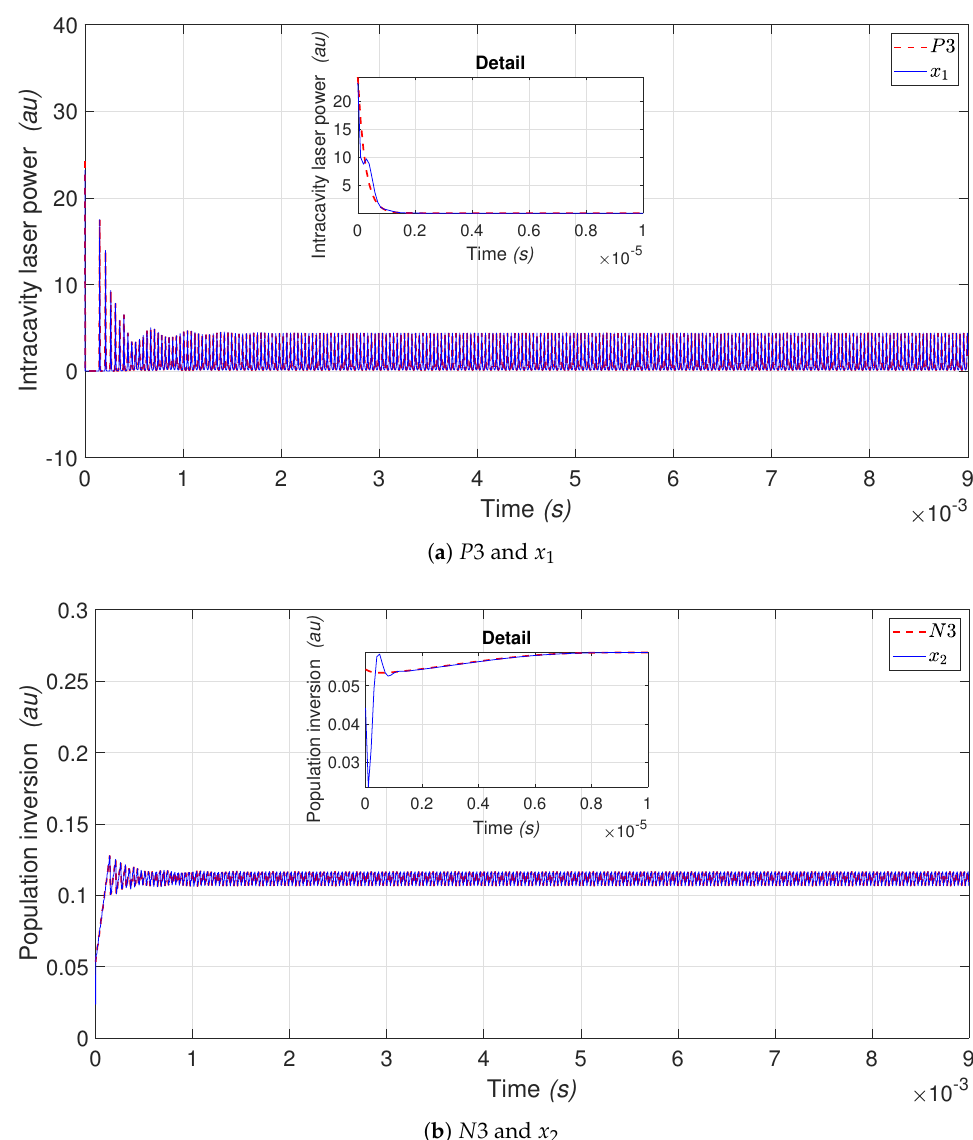
( b ) N 3 and x 2 Figure 5. ( a ) Intracavity laser power P 3 and neural identification x 1 behavior. ( b ) Population inversion N 3 and neural identification x 2 . Table 2. Neural identification results for P 1, P 3, P 4 and P 5 periods. Figure Period (States) Line Initial Condition Convergence Figure 4a P 1 and x 1 Red dashed and blue continuous x = 7.0614 and x 1 = 6.0614 Figure 4b N 1 and x 2 Red dashed and blue continuous y = 0.0095 and x 2 = 0.0075 Figure 5a P 3 and x 1 Red dashed and blue continuous x = 24.2265 and x 1 = 23.2265 Figure 5b N 3 and x 2 Red dashed and blue continuous y = 0.0542 and x 2 = 0.0442 Figure 6a P 4 and x 1 Red dashed and blue continuous x = 5.987 and x 1 = 4.987 Figure 6b N 4 and x 2 Red dashed and blue continuous y = 0.0187 and x 2 = 0.0177 Figure 7a P 5 and x 1 Red dashed and blue continuous x = 91.1913 and x 1 = 90.1913 Figure